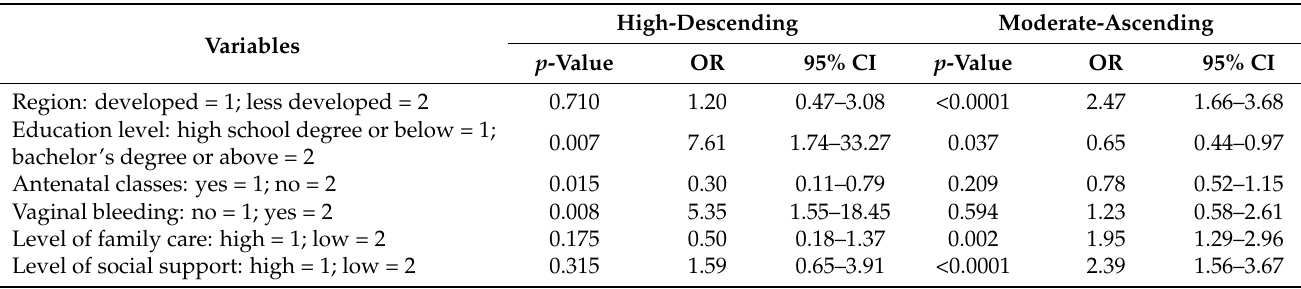
Table 5. Multinomial logistic regression analysis of stress trajectory groups.